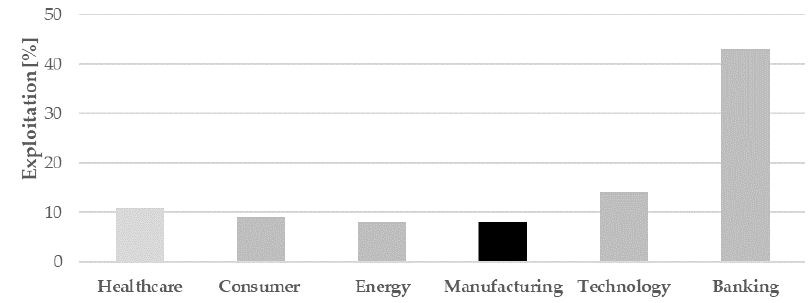
Figure 1. Exploitation of IIoT potential through Big Data Analytics in the main market sectors.